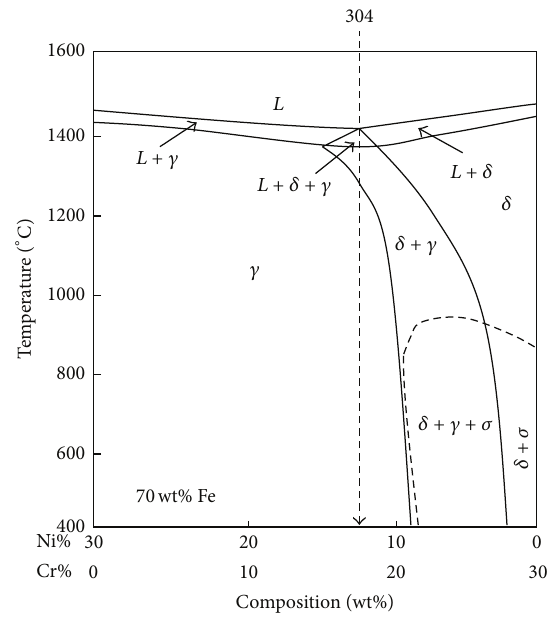
Figure 12: The Fe-Cr-Ni phase diagram. Table 3: XRD data of different crystallographic planes after vibra- tion